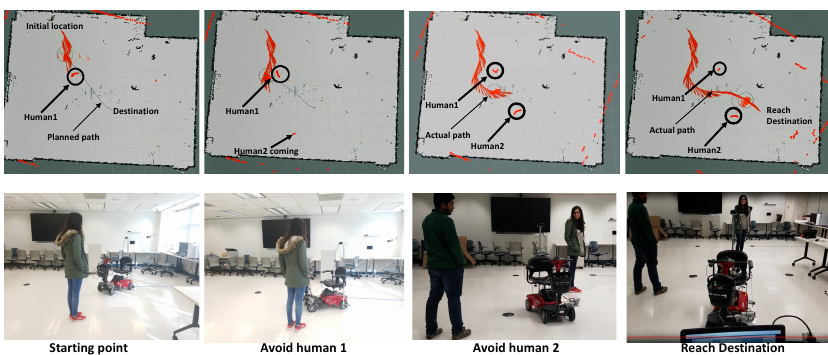
Figure 18. The Dynamic Path Planning and Obstacle